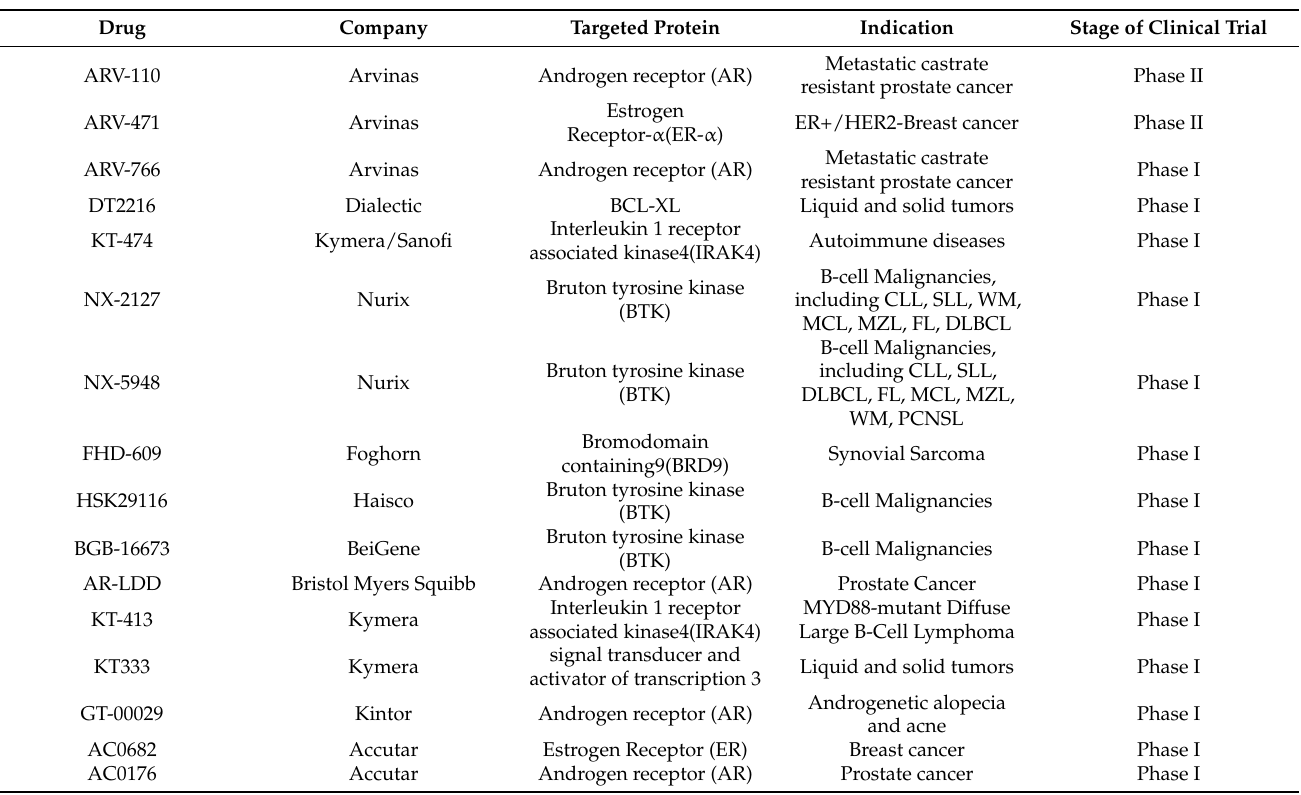
Table 2. The PROTACs entering the clinical